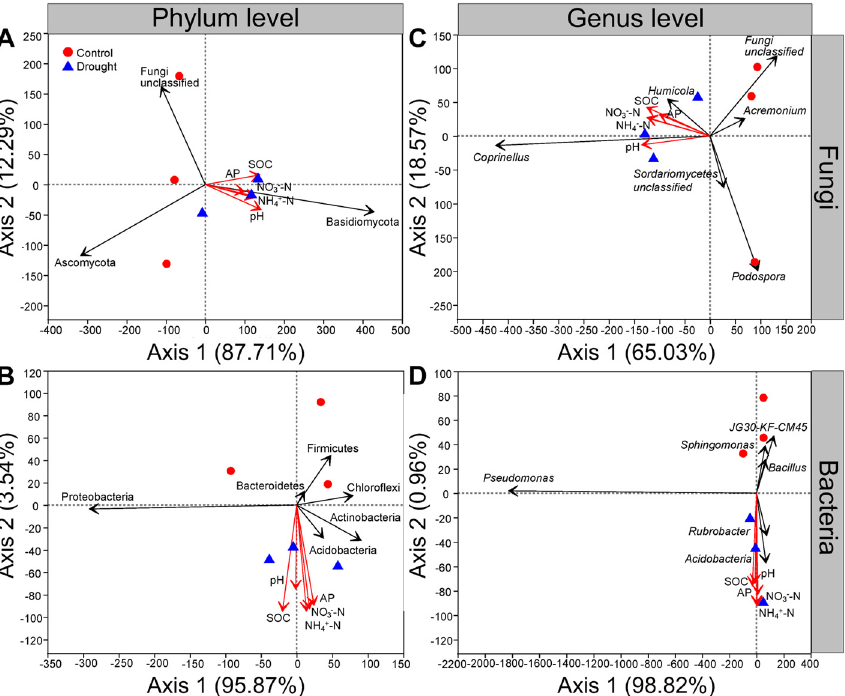
Figure 8. Effects of drought on the relationships among soil microbial communities and soil properties. Redundancy analysis (RDA) of relative abundance of ( A ) soil fungal or ( B ) bacterial community and soil properties at the phylum level, ( C ) soil fungal or ( D ) bacterial community and soil properties at the genus level after L. davurica grown in the glasshouse under drought treatment. The black solid line indicates fungal and bacterial phyla or genera, and the red solid line indicates soil properties. Soil properties indicated include soil organic carbon (SOC), available phosphorus (AP), ammonium nitrogen (NH 4+ -N), nitrate nitrogen (NO 3 − -N) and pH.